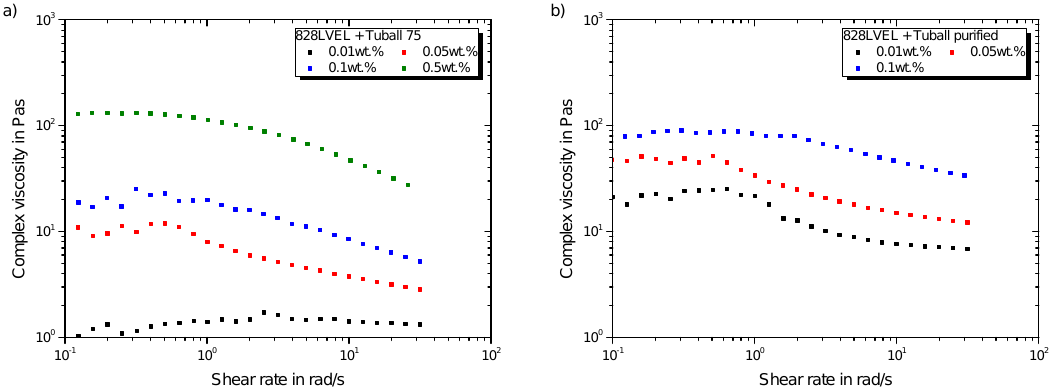
Figure 8. Rheological behavior of SWCNT modified 828LVEL and RIMH137/134 ( a ) Tuball 75 ( b ) Tuball purified.